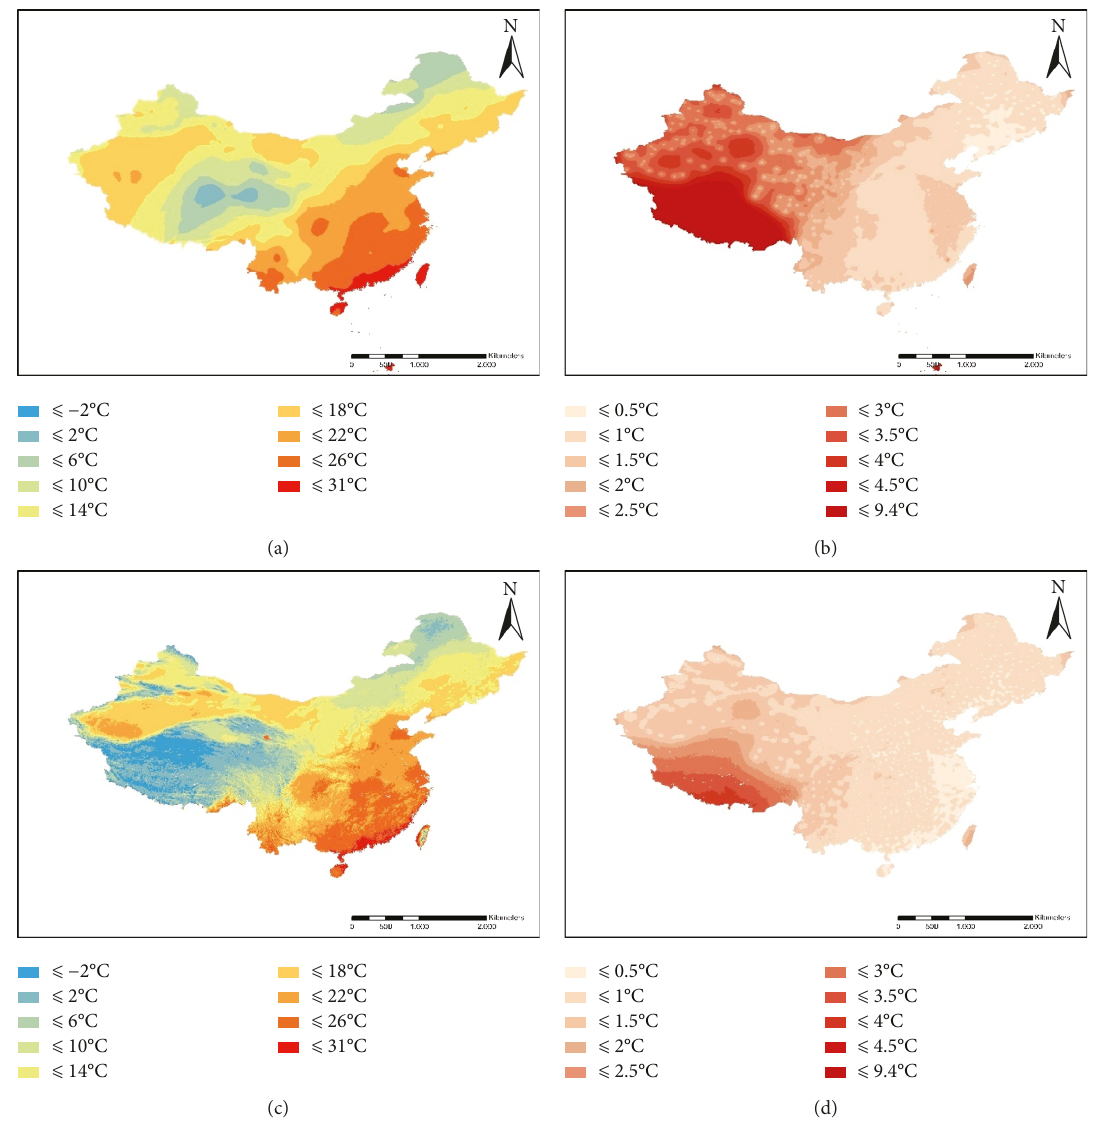
Figure 8: AE interpolation maps of T a -mean with (a) BME-hard and (c) BME-both. (b, d) The corresponding prediction standard error